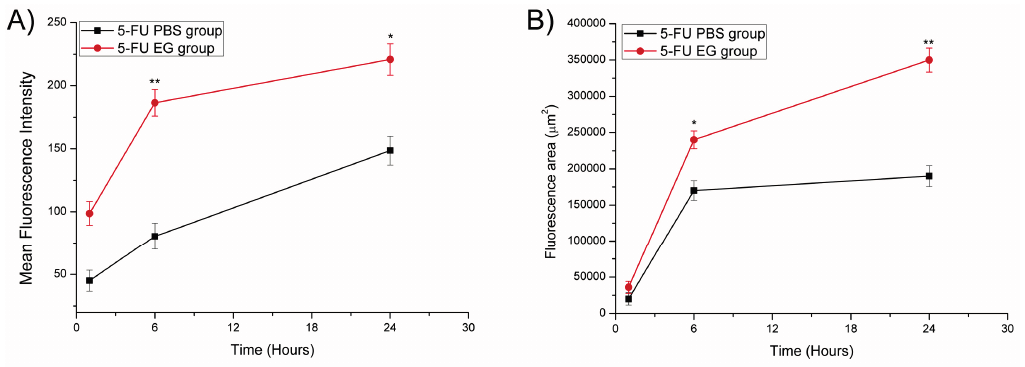
Figure 5. Fluorescence analysis in rabbit scar tissues following application of either ethosomes gel or phosphate buffer saline (PBS) gel containing Rhodamine 6G for 1, 6 and 24 h. Analysis was conducted using Release Version 4.0 SP2 image analysis software (Analytik Jena, Thuringia, Germany). ( A ) Mean fluorescence intensity of EGs vs. PBS gels; ( B ) Fluorescent areas of EGs vs. PBS gels. All time points represent the mean ± SD ( n = 6). * represents p < 0.05 and ** represents p <